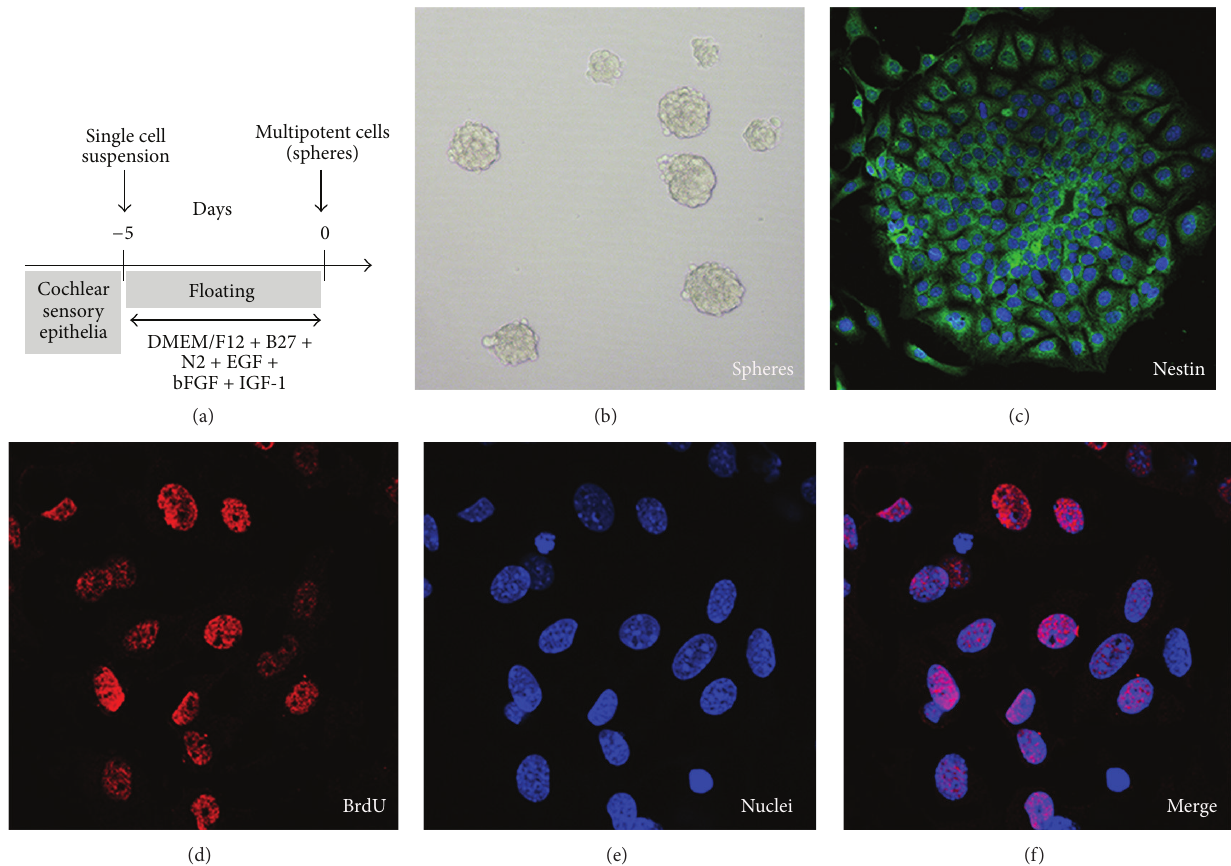
Figure 1: Characterization of spheres from the cochlear epithelia of newborn mice. (a) The cochlear sensory epithelia of P0 ICR mice were dissociated into single cells and cultured in suspension plates for 5 days to form spheres in presence of EGF, bFGF, and IGF-1, as indicated. (b) A bright-field view of a typical sphere generated after 5 days of in vitro culture. (c) Sphere cells expressed the neuronal stem cell marker Nestin (green). (d) Shortly after dissociation, most sphere cells were immunoreactive for 5-bromo-2 󸀠 -deoxyuridine (BrdU) incorporation into the genomic DNA (red, left). (e) The nuclei of the sphere cells were stained with DAPI (blue). (f) The merging of BrdU immunostaining (red) and DAPI staining